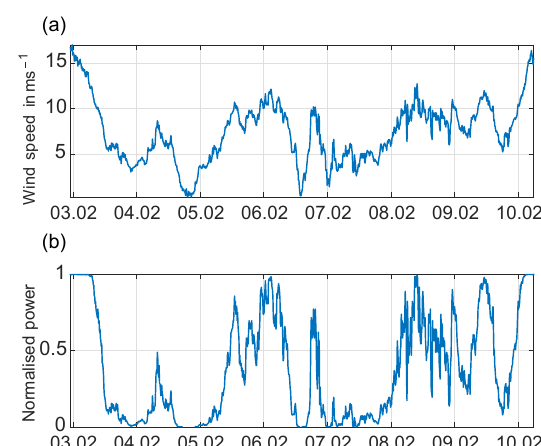
Figure 3. Analysed study domain to calculate the spatial variability of the wind and solar